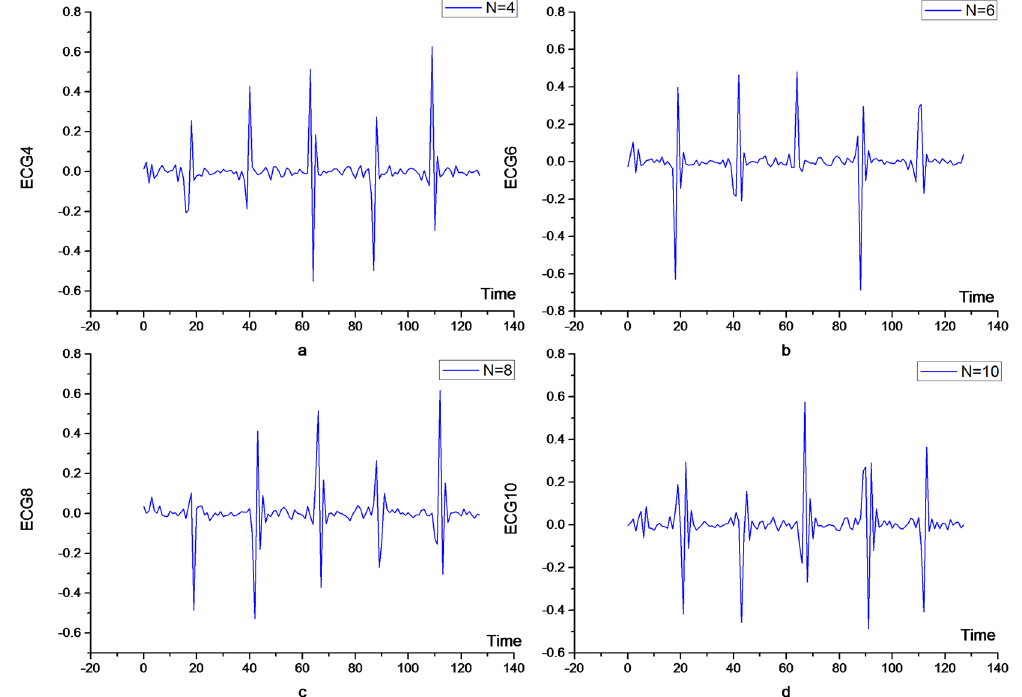
Figure 6. High frequency component of the ECG signal through the N-order vanishing moment filter.